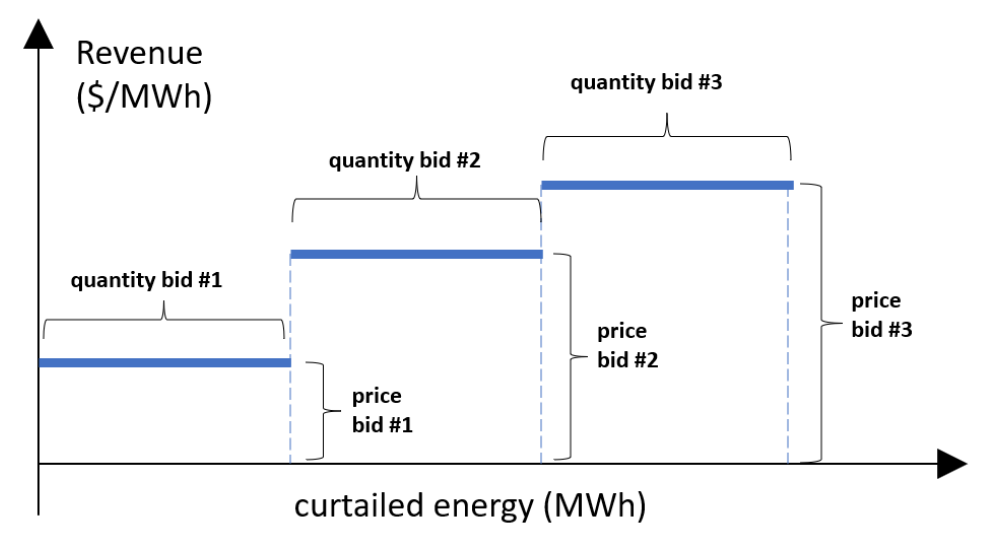
Figure 2. Price–quantity bid curves for demand response